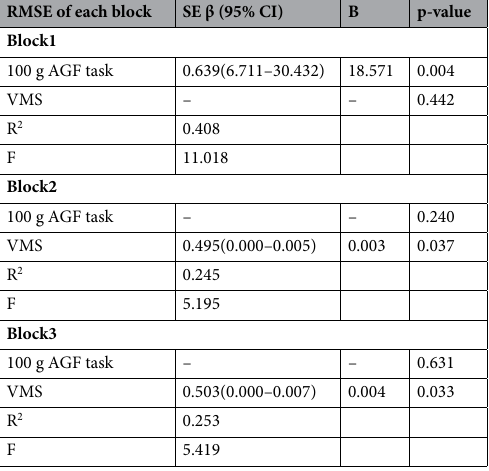
Table 1. The multivariable linear regression analysis of each block in the acquisition phase for the older adult group. SE β standardised coefficient, CI confidence interval, RMSE Root Mean Square Error, VMS visual- motor